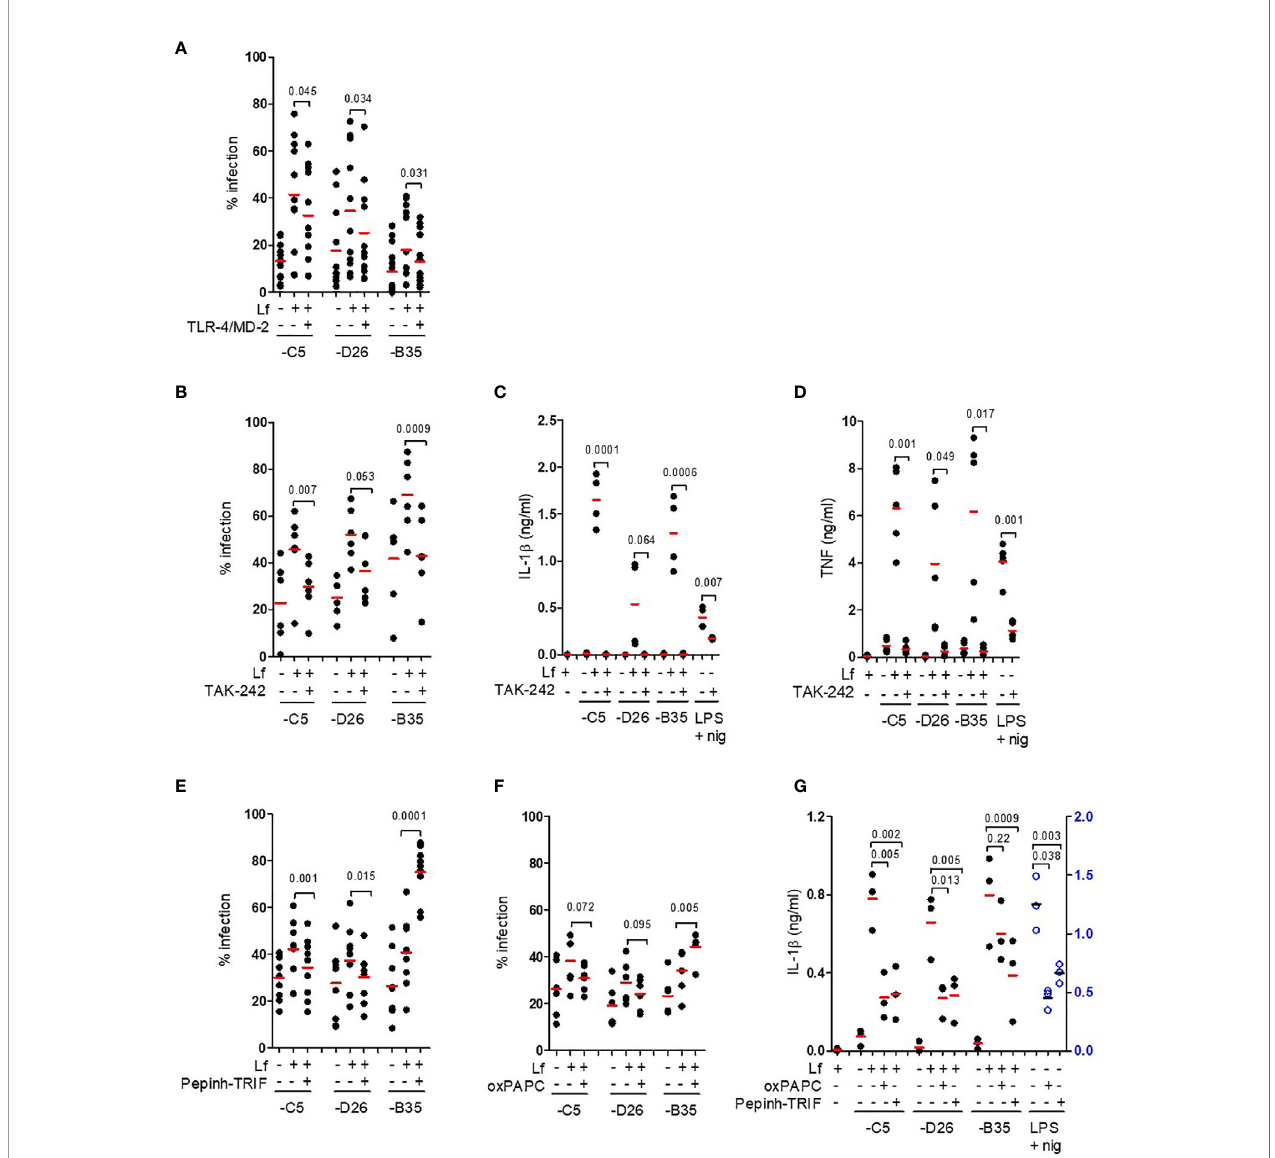
FIGURE 3 | TLR4 engagement and signalling involved in HAdV-lactoferrin DC uptake and maturation. (A) HAdV-lactoferrin complexes were incubated with recombinant TLR4/MD-2 for 30 min. and then added to DCs. Uptake was quanti fi ed 24 h post-incubation by fl ow cytometry (n =11, statistical analyses by two-tailed paired t-test); (B) DCs were pre-treated for 1 h with TAK-242, HAdV-lactoferrin complex uptake was analysed 24 h post-incubation by fl ow cytometry (n = 6, statistical analyses by two-tailed paired t-test); (C) IL-1 b release following pre-treatment with TAK-242 (n ≥ 3 statistical analyses by t-test); (D) TNF levels 24 h post- incubation ± TAK-242 (n ≥ 3, statistical analyses by two-tailed paired t-test); (E) Percent infection following inhibition with Pepinh-TRIF (n ≥ 6, statistical analyses by two-tailed paired t-test); (F) Percent infection following inhibition with oxPAPC (n ≥ 6, statistical analyses by two-tailed paired t-test); (G) IL-1 b release from DCs incubated with HAdV-lactoferrin ± oxPAPC and Pepinh-TRIF (n = 3, statistical analyses by two-tailed paired